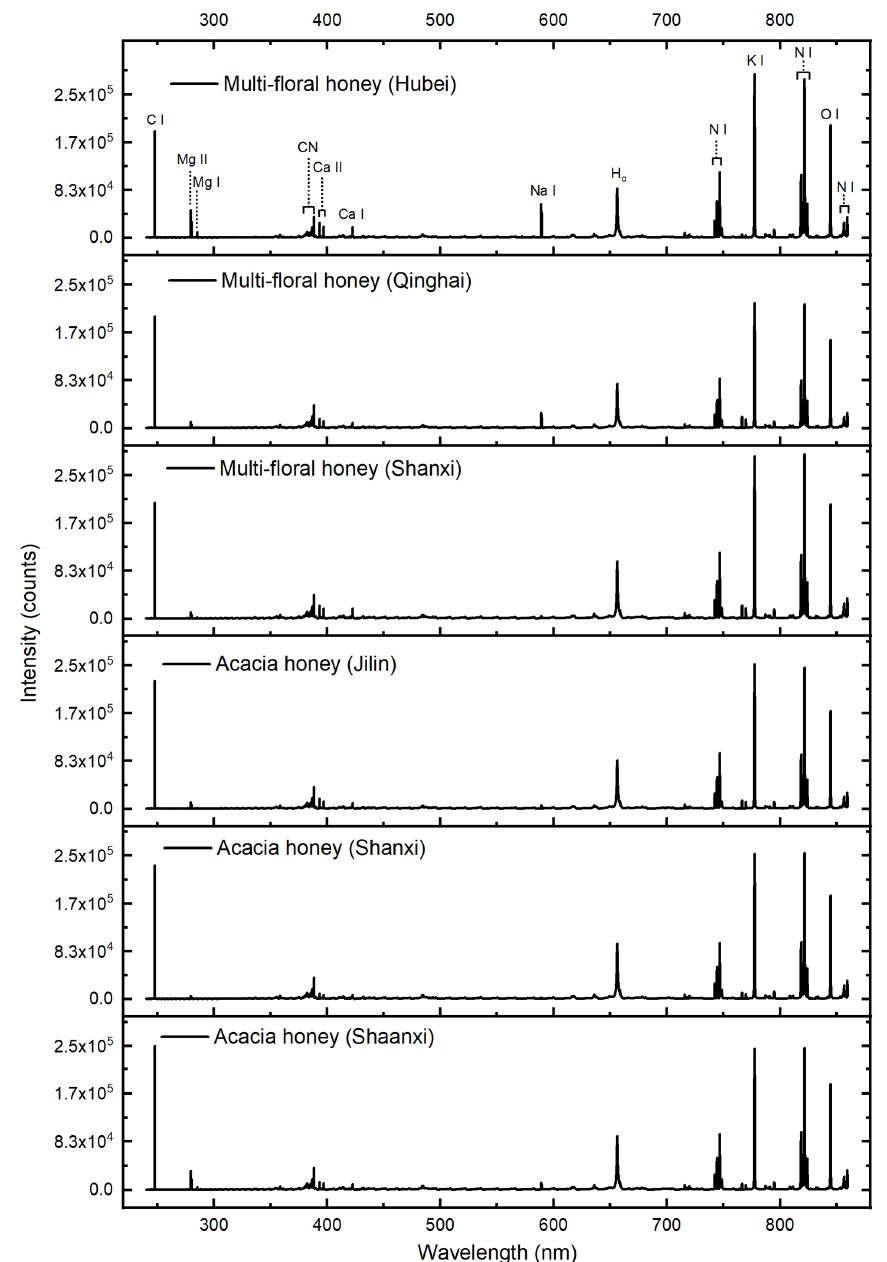
Figure 1. Spectral fingerprints of honeys from different geographical origins.